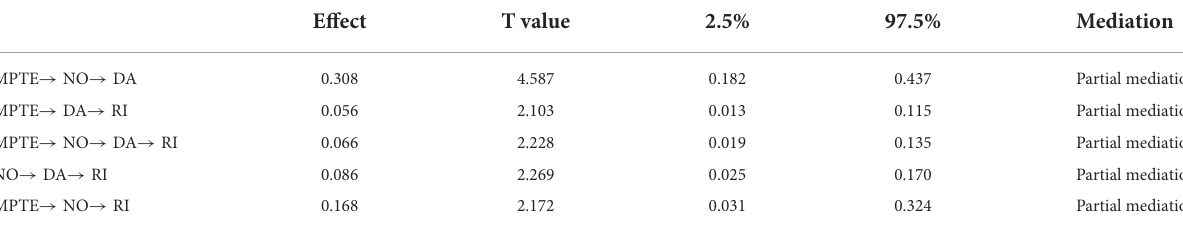
TABLE 6 The mediation effect of place identity and life